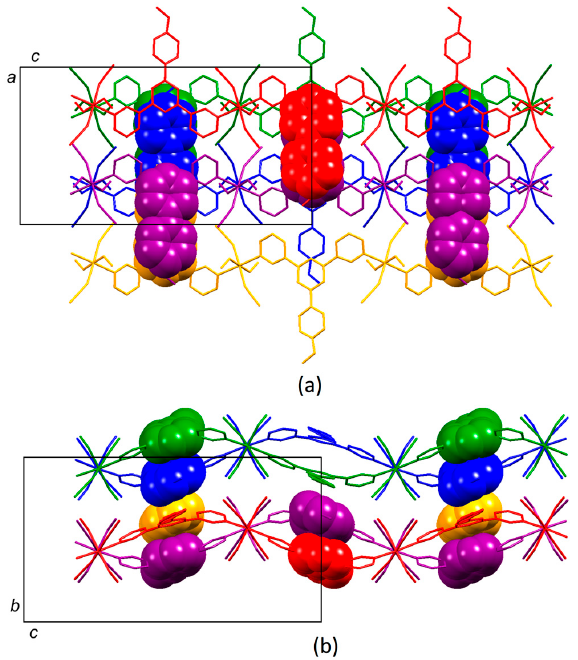
Figure 5. Packing of chains in [Co( 2 )(NCS) 2 (MeOH) 2 ] n . View down the b -axis showing head-to-tail π -stacking between 4-methoxyphenylpyridine units of pairs of ligands 2 .